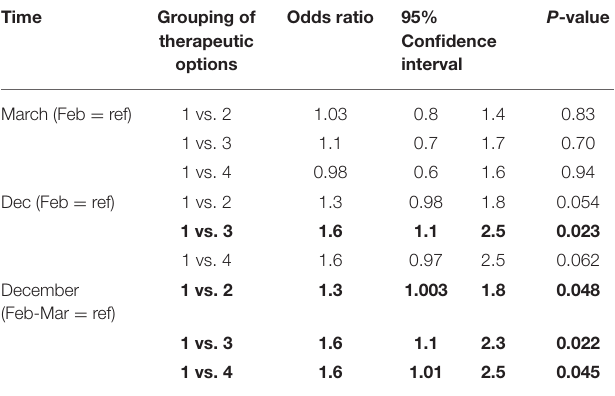
TABLE 5 | Univariate analysis of the effect of timing on physician prescribing continued LT4 vs. increasing LT4 vs. adding LT3 to LT4 vs. replacing LT4 with T3-containing